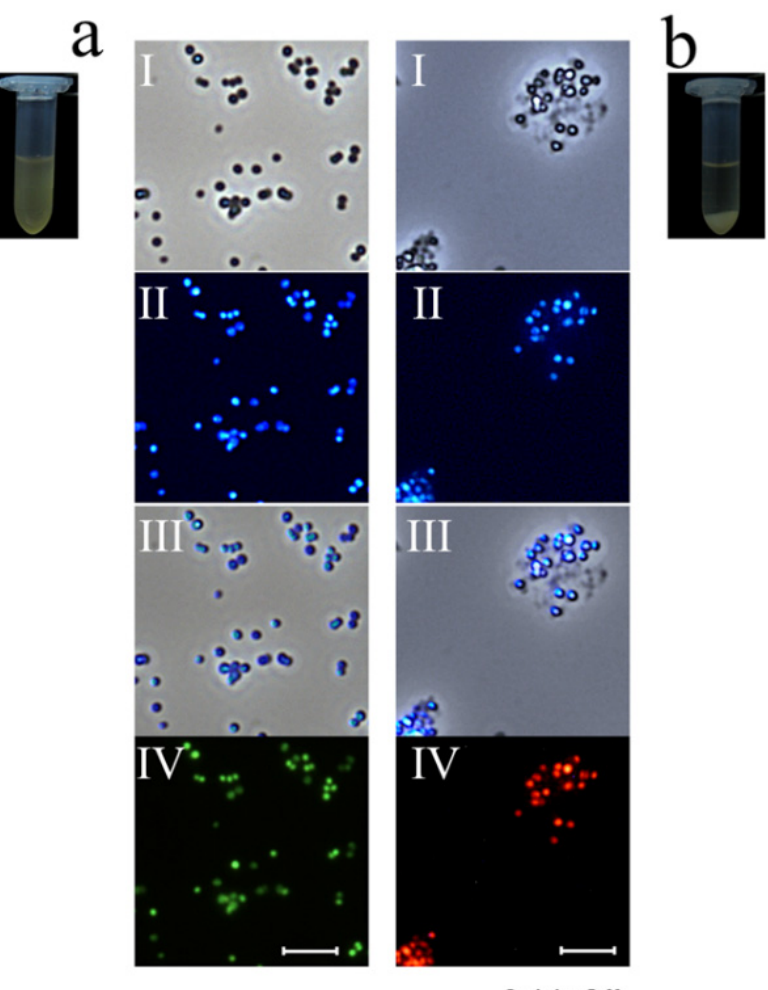
Figure 8. ( a ) TGQD treated VRSA at 0 h where (I) stands for the phase contrast image of VRSA, (II) stands for UV excitation image, (III) denotes ‘I’ and ‘II’ merged cells, and (IV) denotes SYTO9 (living cells green fluorescence) and propidium iodide (dead cells red fluorescence) stained cells. ( b ) TGQD treated VRSA in 4 h where (I) stands for the phase contrast image of VRSA, (II) stands for UV excitation image in phase contrast microscope, (III) denotes ‘I’ and ‘II’ merged cells, and (IV) SYTO9 and propidium iodide stained cells fluorescence image.